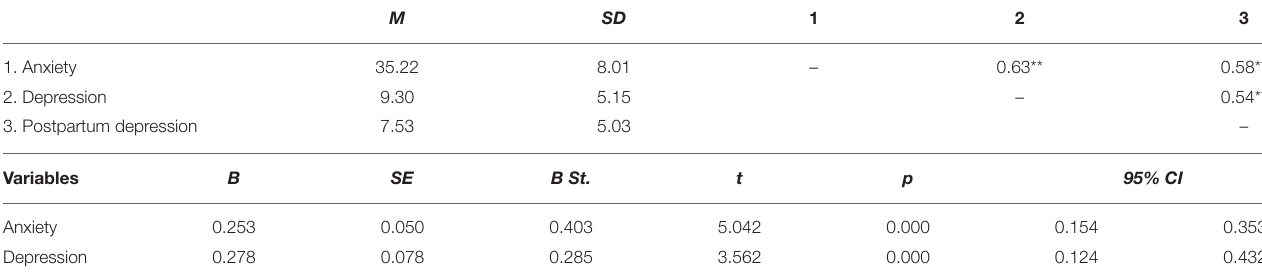
TABLE 2 | Descriptive statistics, correlations and summary of the linear regression analysis with psychopathological characteristics as independent variables for PPD score.